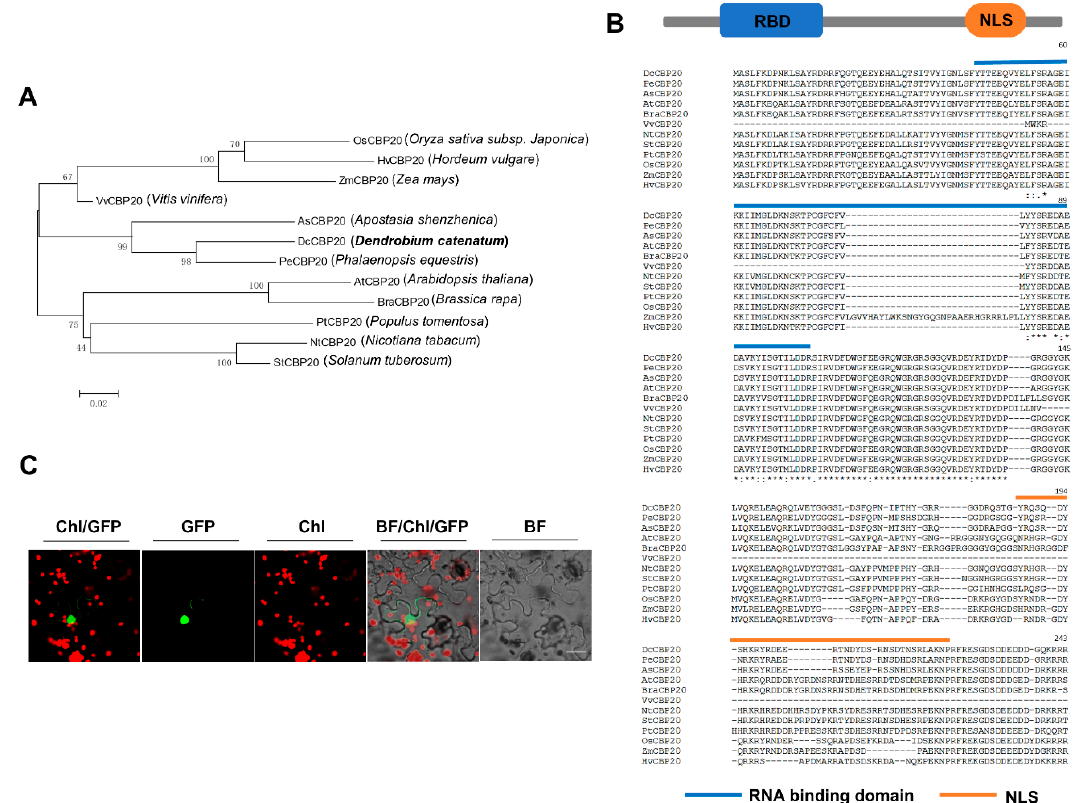
Figure 8. Functional analysis of CBP20 homologues in D. catenatum . ( A ) Phylogenetic analysis of CBP20 homologues in six representative dicotyledonous species and five monocotyledonous species. ( B ) Sequencing alignment and conserved motif prediction of CBP20 homologues. ( C ) Subcellular localization of DcCBP20-GFP in tobacco leaves. The DcCBP20-GFP construct was transiently expressed in the leaves of Nicotiana benthamiana (bar = 10 μ m), and GFP fluorescence was observed.